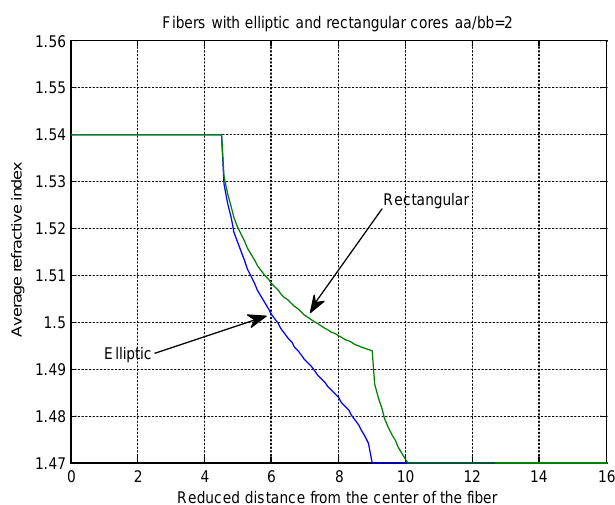
Figure 8. Average refractive indexes of circular thin layers of elliptic and rectangular core fibers.